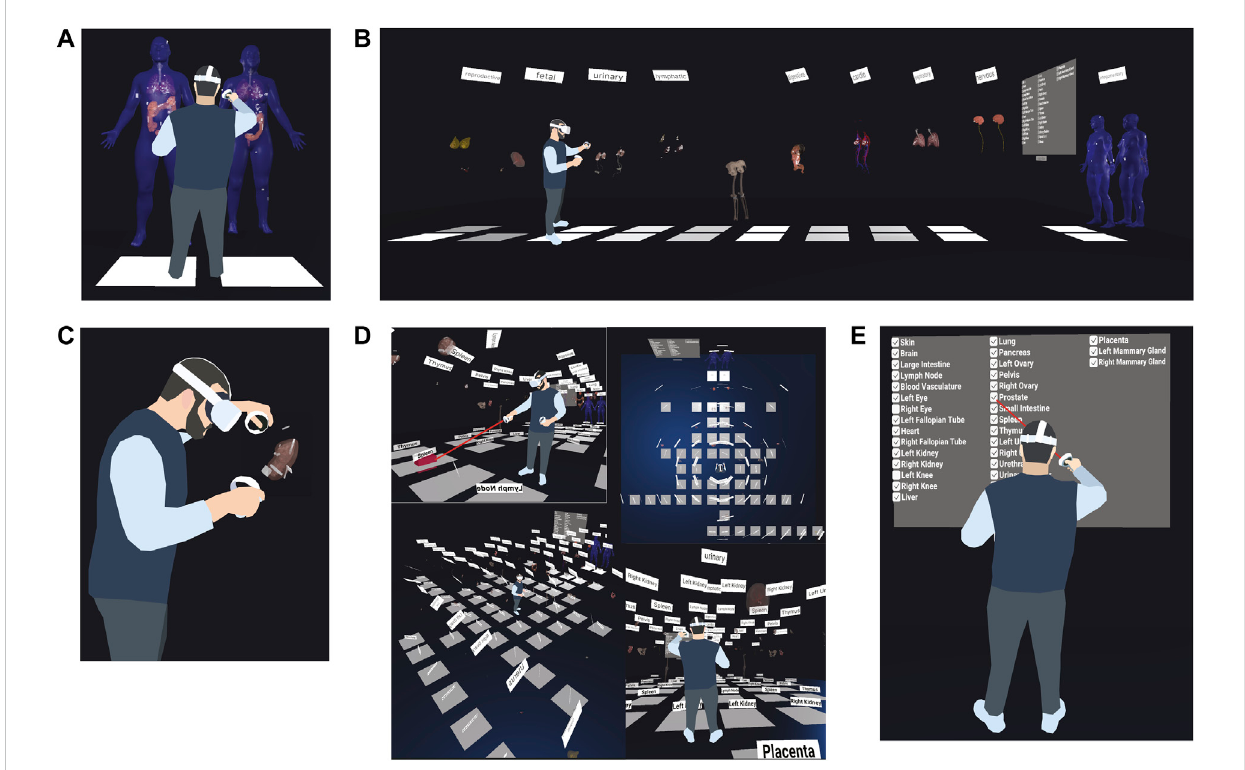
FIGURE 2 FunctionalityoftheHRAOrganGalleryv0.6. (A) Defaultorganlayout (B) Auserextrudesall10bodysystemscontaining55organs. (C) Auserinspects a kidney and tissue blocks. (D) A user moves through the scene using teleportation, plus other views of the fully extruded gallery view. (E) A user employs the fi lter menu to show or hide